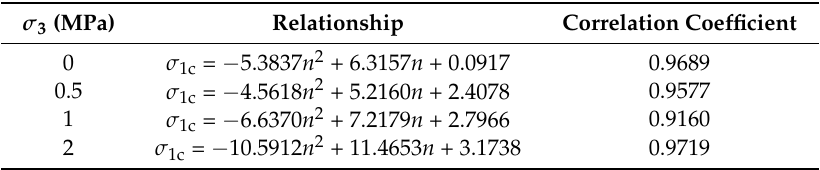
Table 5. Relationships between the peak strength and Talbot index of CPB specimens under different confining